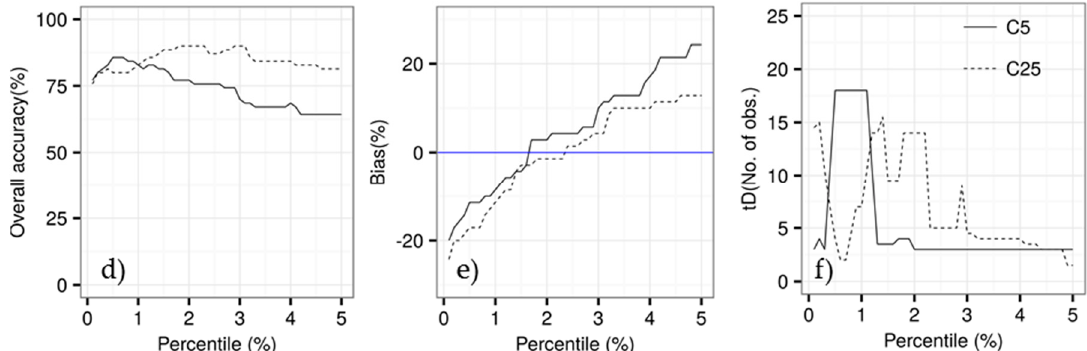
Figure 6. Change in the overall accuracy, bias, and the median temporal detection delay (tD) as a function of the percentile for defining deforestation as extreme event in Landsat space-time data cubes (C5 and C25) at the Bolivian ( a – c ) and Brazilian ( d – f ) study sites. The blue lines denote zero bias. Bias was calculated by subtracting the omission error from the commission error ([11]).